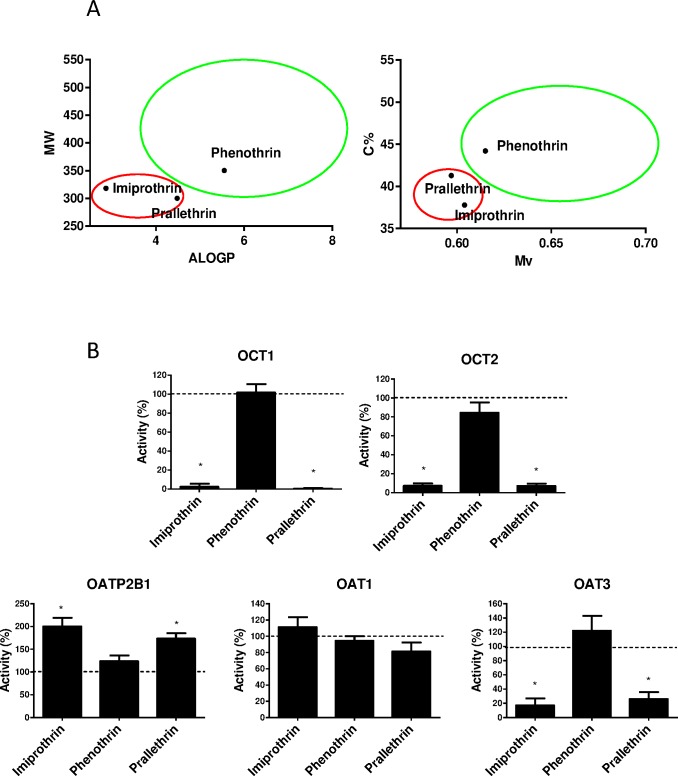
Effects of imiprothrin, phenothrin and prallethrin on OCT1, OCT2, OATP2B1, OAT1 and OAT3 activities.(A) Imiprothrin, phenothrin and prallethrin were projected on graphs MW (molecular weight) versus ALOGP (Ghose-Crippen-Viswanadhan octanol-water partition coefficient) (Right panel) and C % (percentage of C atoms) versus Mv (mean atomic van der Waals volume, scaled on Carbon atom) (Left panel). Red and green circles were placed exactly as defined in Fig 7 and putatively discriminated pyrethroids interacting with drug transporters (red circle) from those that do not it (green circle). (B) Activities of OCT1, OCT2, OATP2B1, OAT1 and OAT3 were determined in transporter-transfected HEK cells in the absence or presence of reference inhibitors or of imiprothrin, phenothrin or prallethrin (each used at 100 μM), as described in Materials and Methods. Data are expressed as percentages of activities found in untreated control cells, arbitrarily set at 100% and indicated by dotted lines on graphs; they are the means ± SEM of at least three independent assays, each being usually performed in triplicate. *, p<0.05 when compared to untreated control cells.